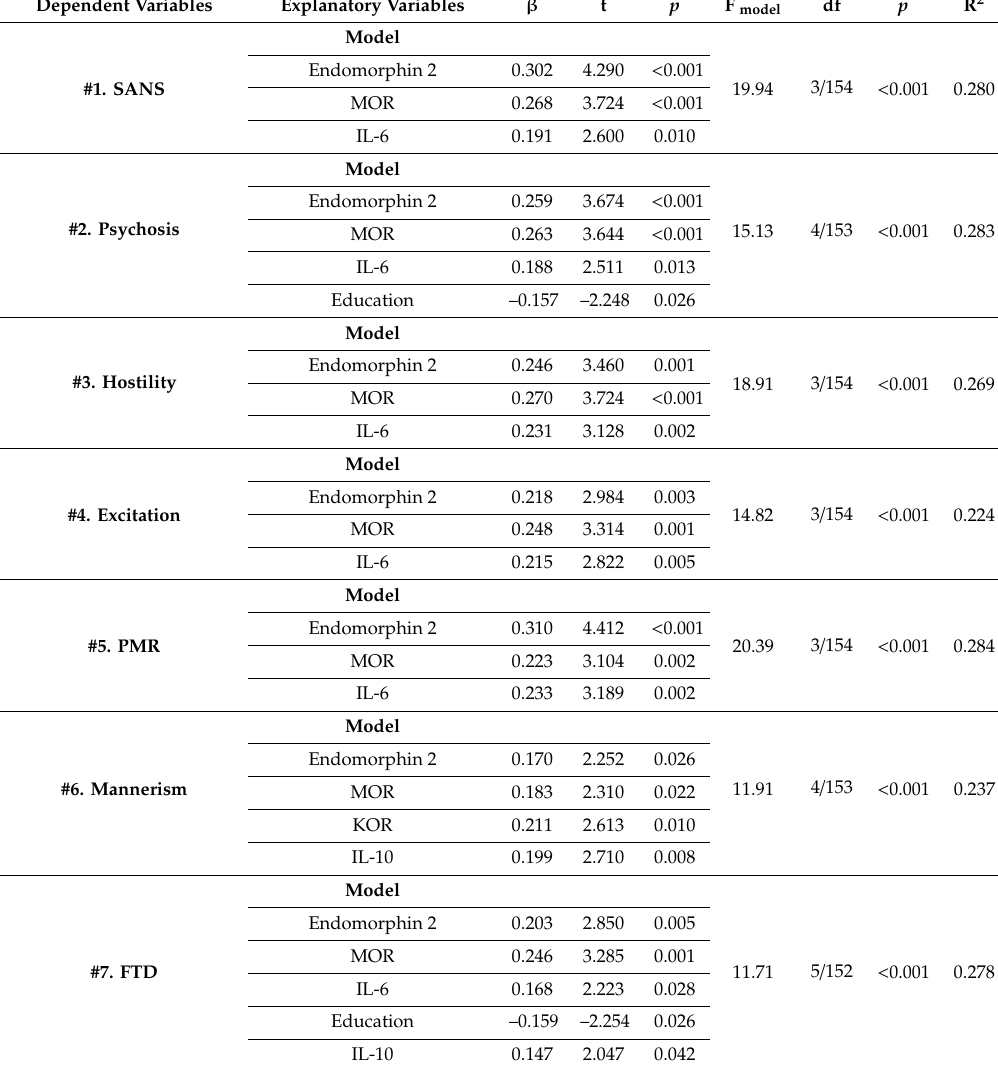
Table 6. Results of multiple regression analysis with schizophrenia symptom domains as dependent